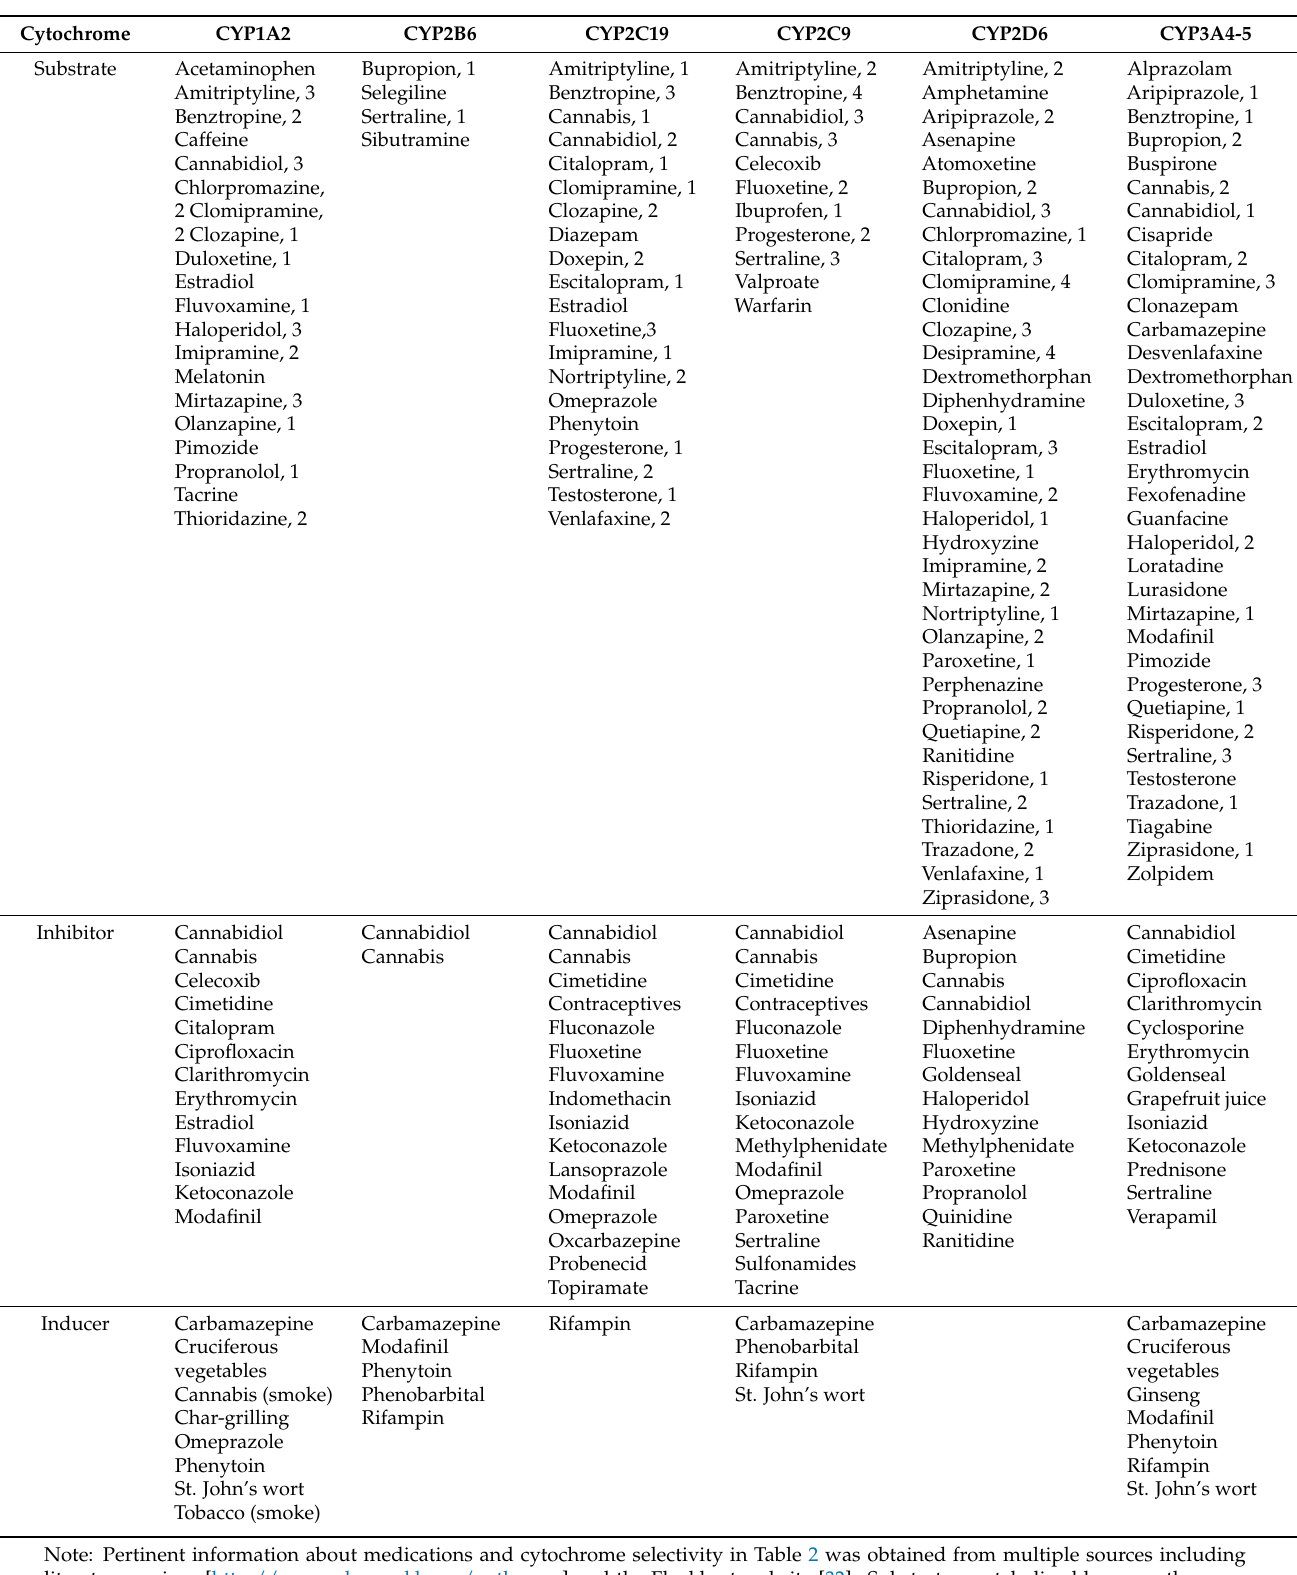
Table 2. Psychotropic medications, nutraceuticals, agents, and related cytochrome P450